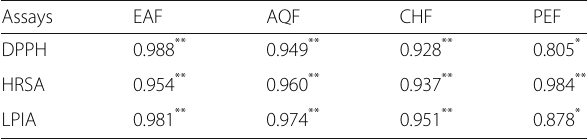
Table 2 Correlation coefficients between the antioxidant capacity and phenolic content of various fractions of T. pallida leaves Assays EAF AQF CHF PEF DPPH 0.988 ** 0.949 ** 0.928 ** 0.805 * HRSA 0.954 ** 0.984 ** LPIA 0.981 ** 0.974 ** 0.951 ** 0.878 * Each value in the table is represented as mean±SD (n=3). * indicates significance at * P <0.05, ** P